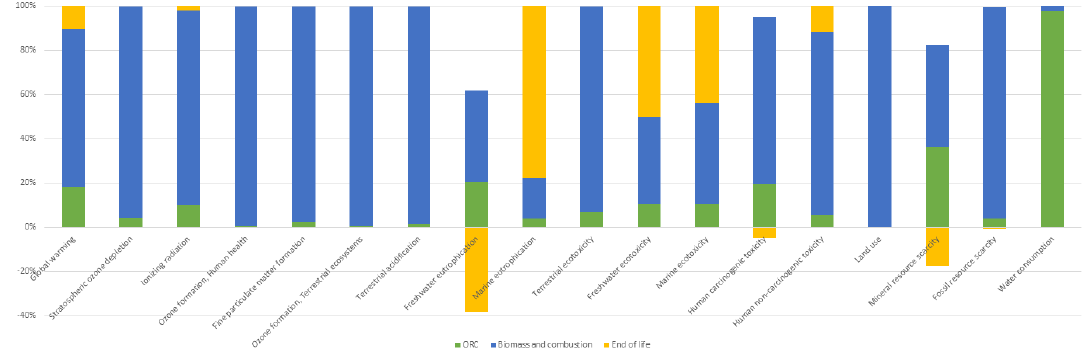
Figure 3. Contribution of operations in full electric mode (ReCiPe 2016 method).